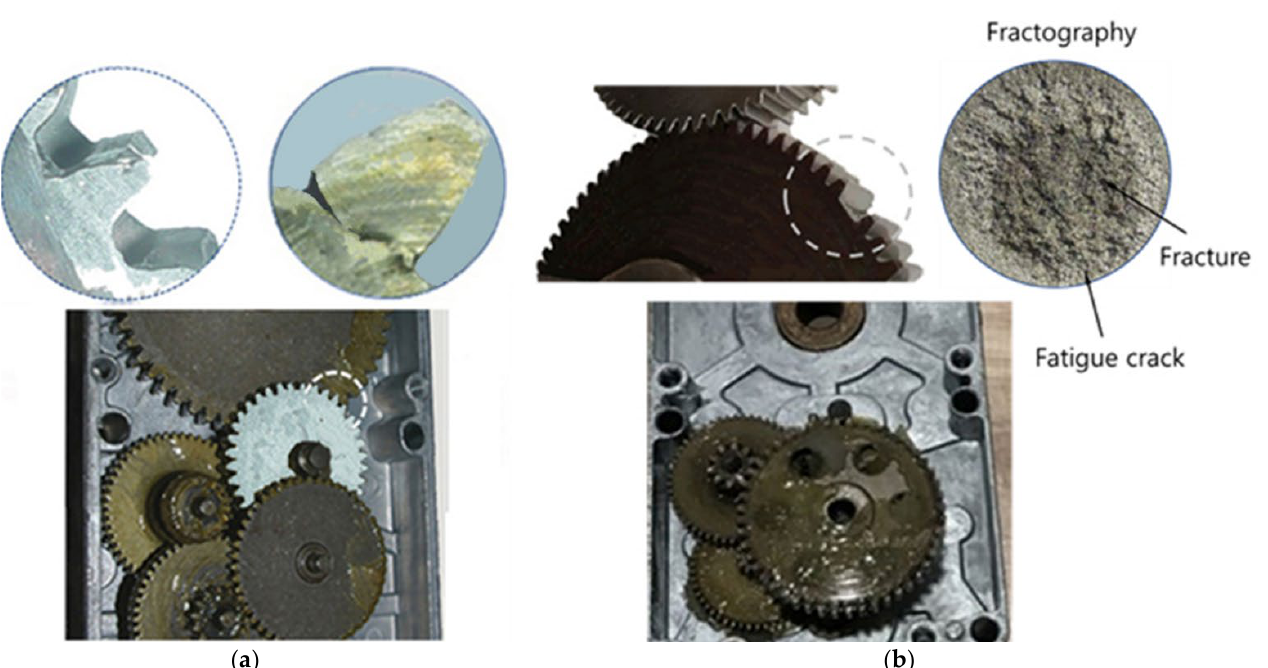
Figure 12. Failed gear systems. ( a ) Unsuccessful product in the market; ( b ) fractured product after the first ALT.